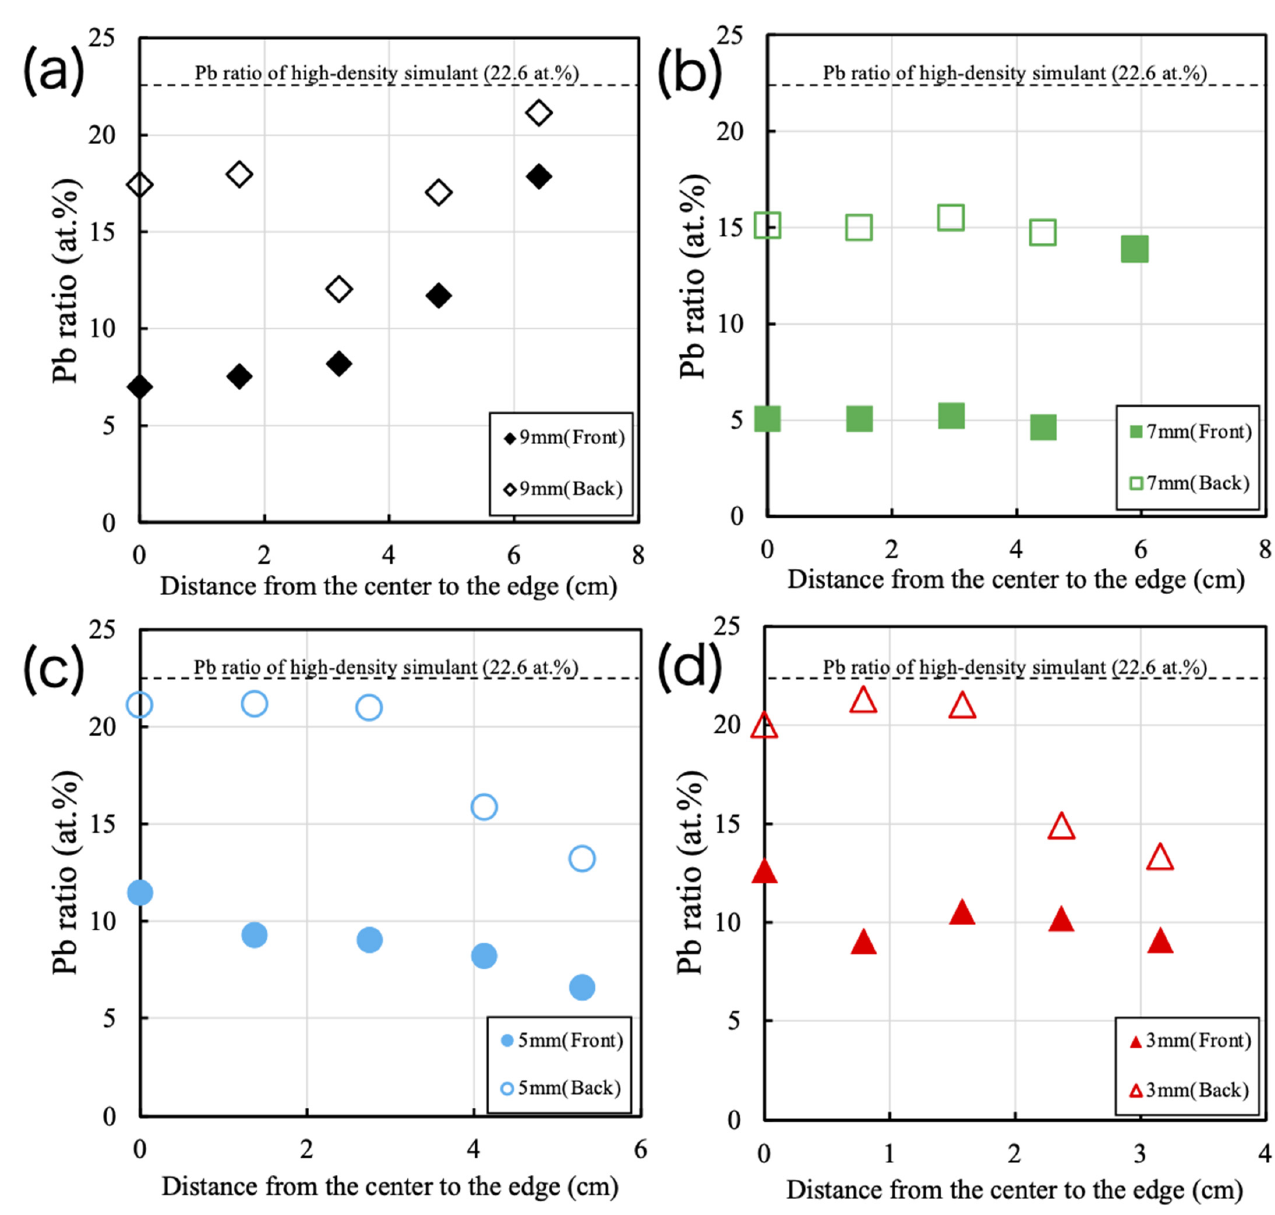
Figure 8. Pb distribution in the solidified metal under the reverse density stratification ( a ) 9 mm outlet, ( b ) 7 mm outlet, ( c ) 5 mm outlet, ( d ) 3 mm outlet.